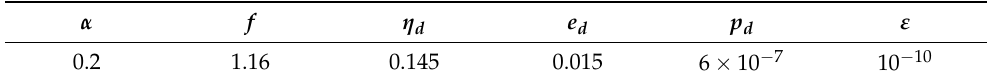
Table 1. List of experimental parameters applied in the numerical simulation in the following table: α (dm/km) is the loss coefficient of the fiber, f is the efficiency of error correction, η d is the efficiency for the Charlie-side detector, e d is the optical misalignment error rate, p d is the dark count for detectors, and ε is the predetermined security bound.